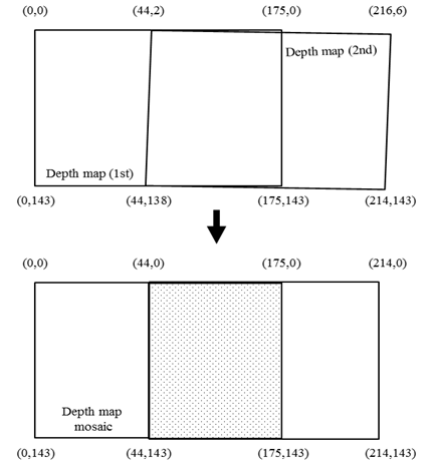
Figure 3. Deciding area of mosaic image